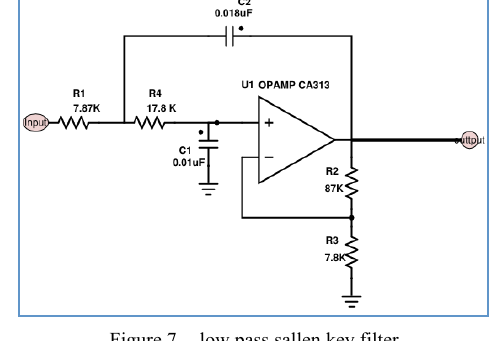
Figure 7. low pass sallen key filter